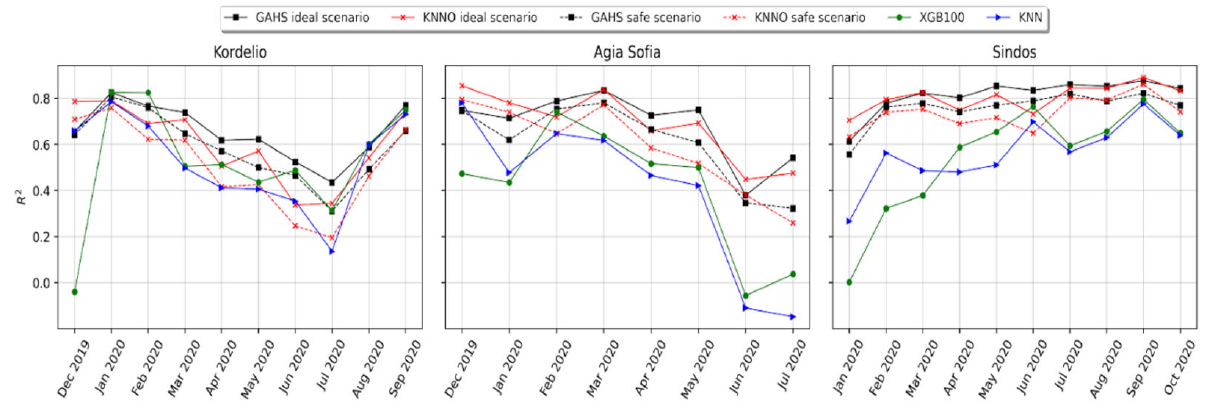
Figure 9. Comparison between the GAHS and the SOL frameworks and the best performing batch models in terms of the coefficient of determination for O 3 .